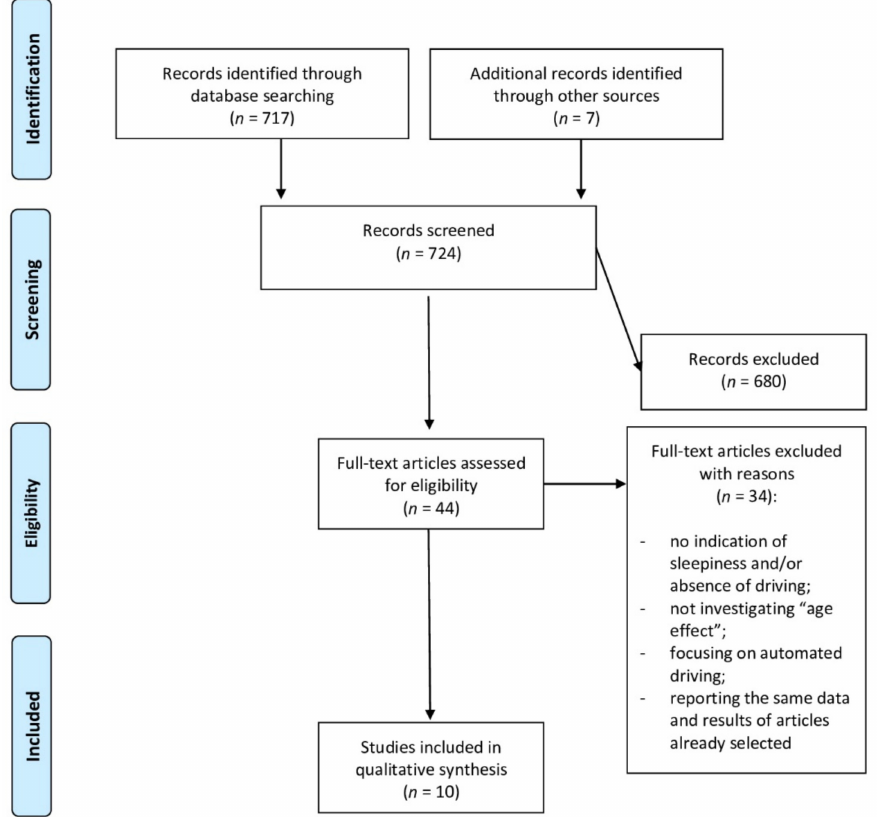
Figure 1. Flowchart of the article selection